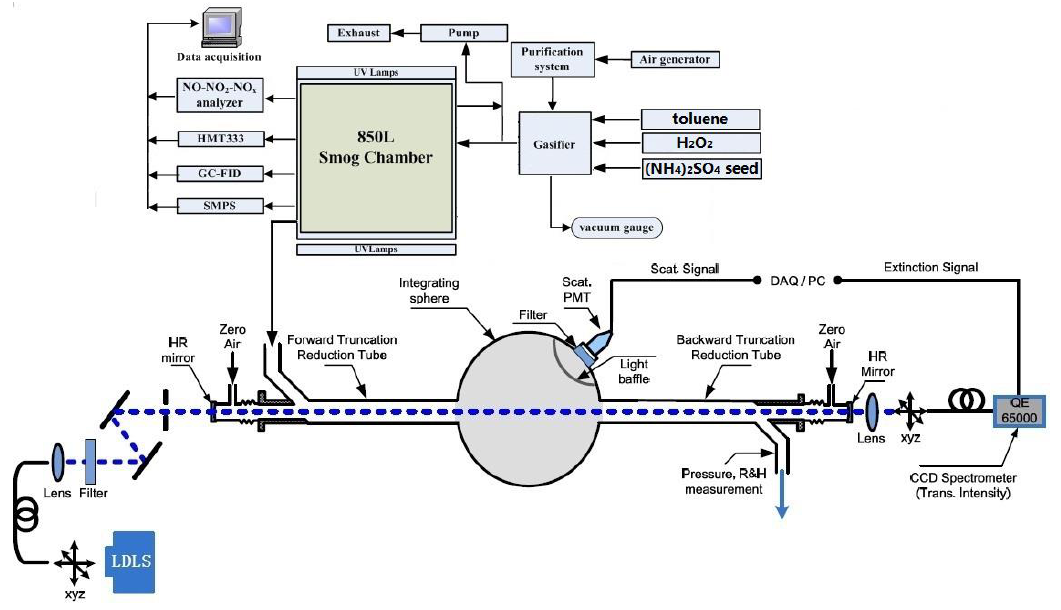
Figure 1. Schematic diagram of the aerosol albedometer and chamber.